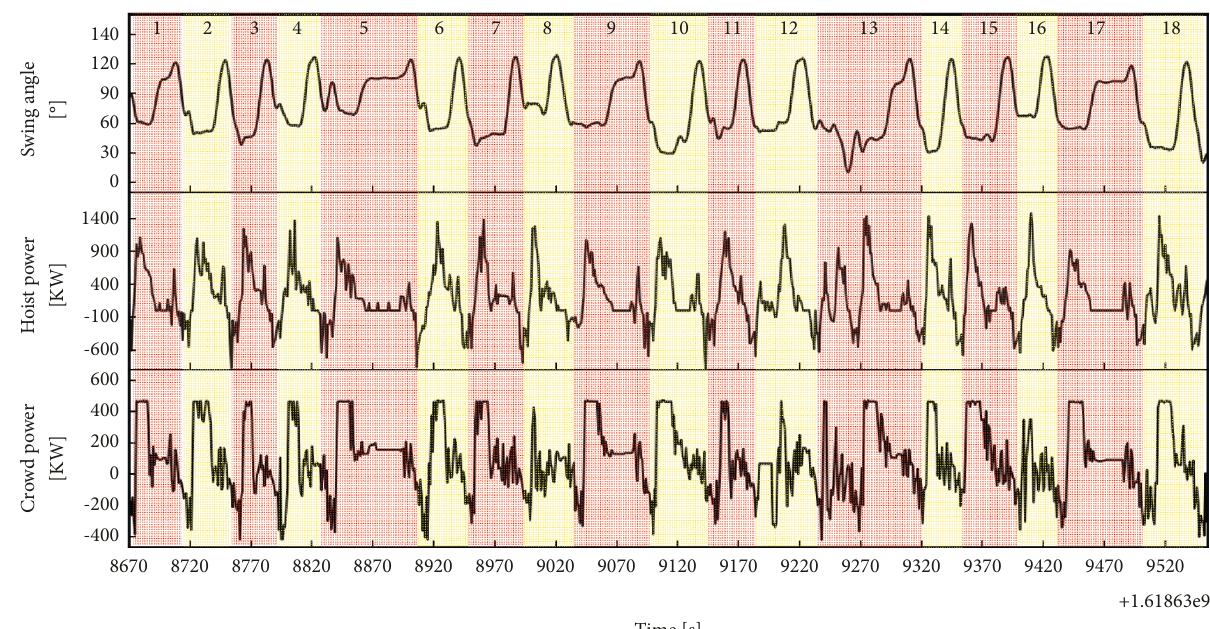
Figure 5: Automatic identification of the loading cycles based on monitoring data.